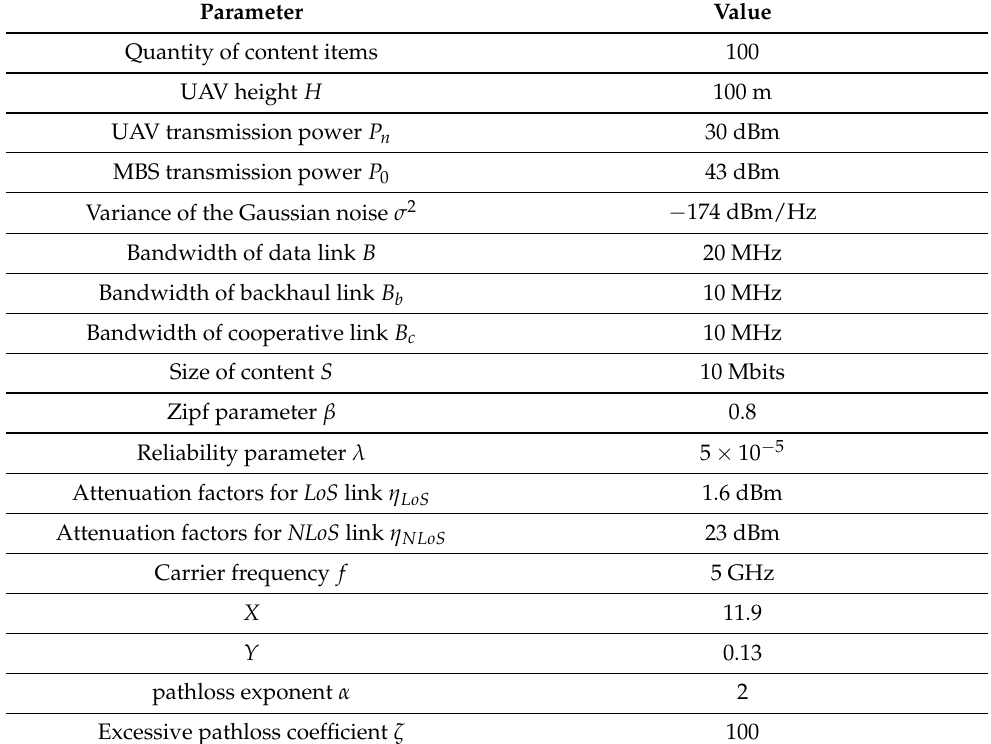
Table 2. Simulation